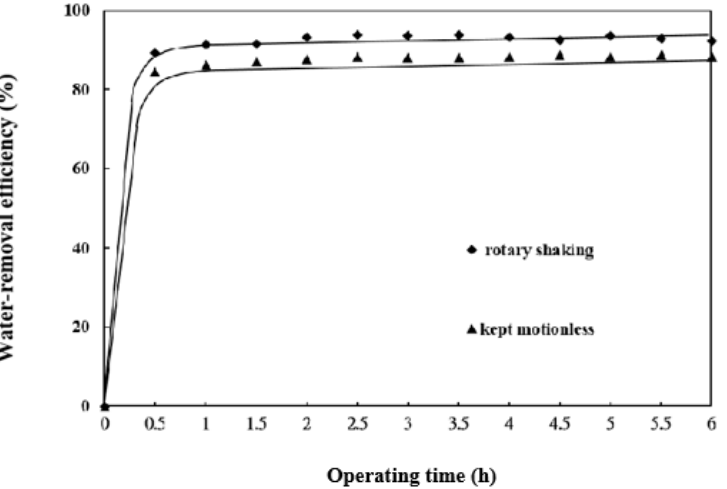
Figure 7. Comparison of water-removal efficiency of molecular sieves from ethanol under motionless and rotary shaking conditions.